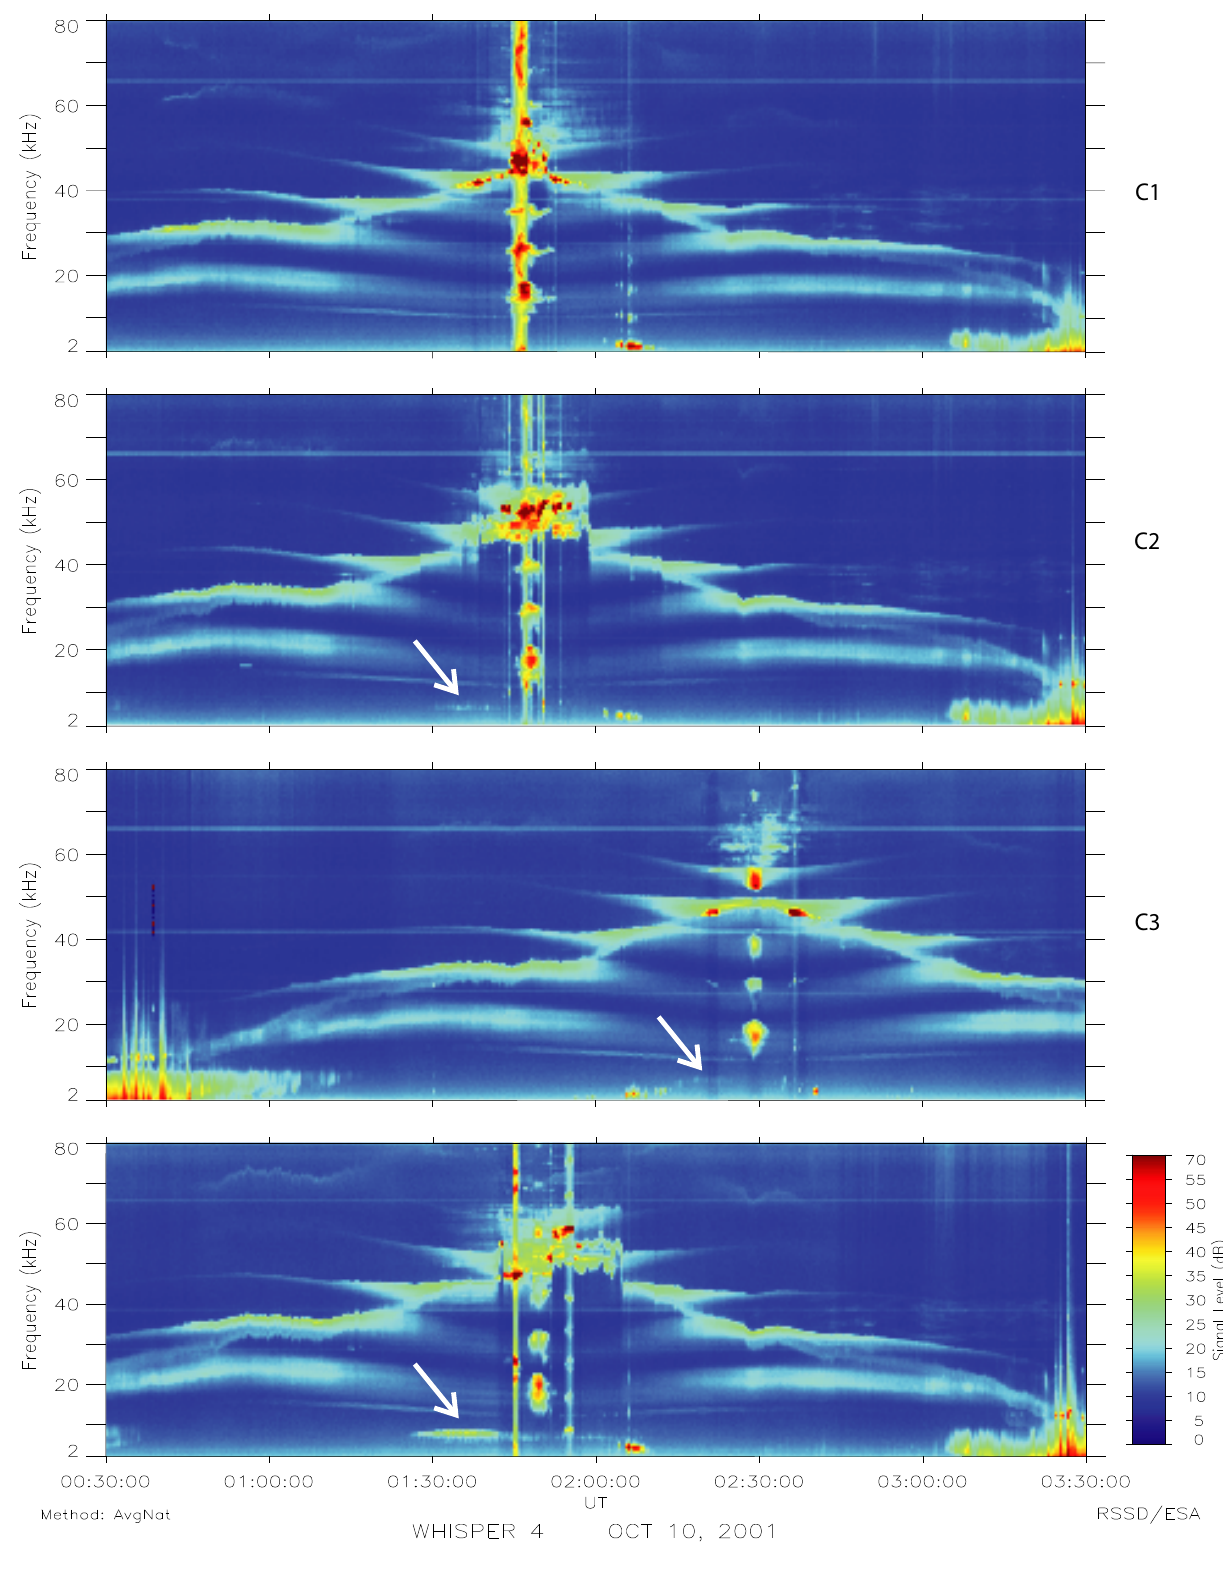
Fig. 4. WHISPER spectrograms measured by the four Cluster spacecraft on 10 October 2001, 00:30–03:30 UT. Note the presence of a short duration banded hiss-like emission, just after 01:30 on C4 and C2 (far less intense), and barely distinguishable 45min later on